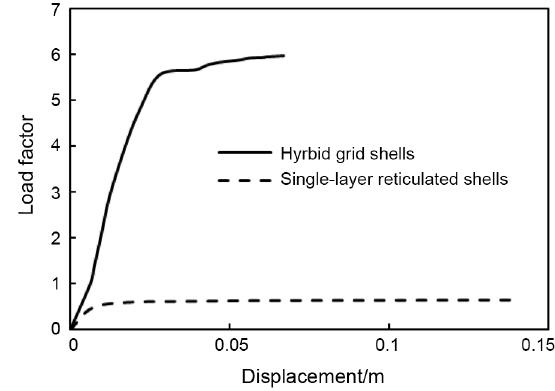
Fig. 4. Load factor vs. displacement for different structural systems